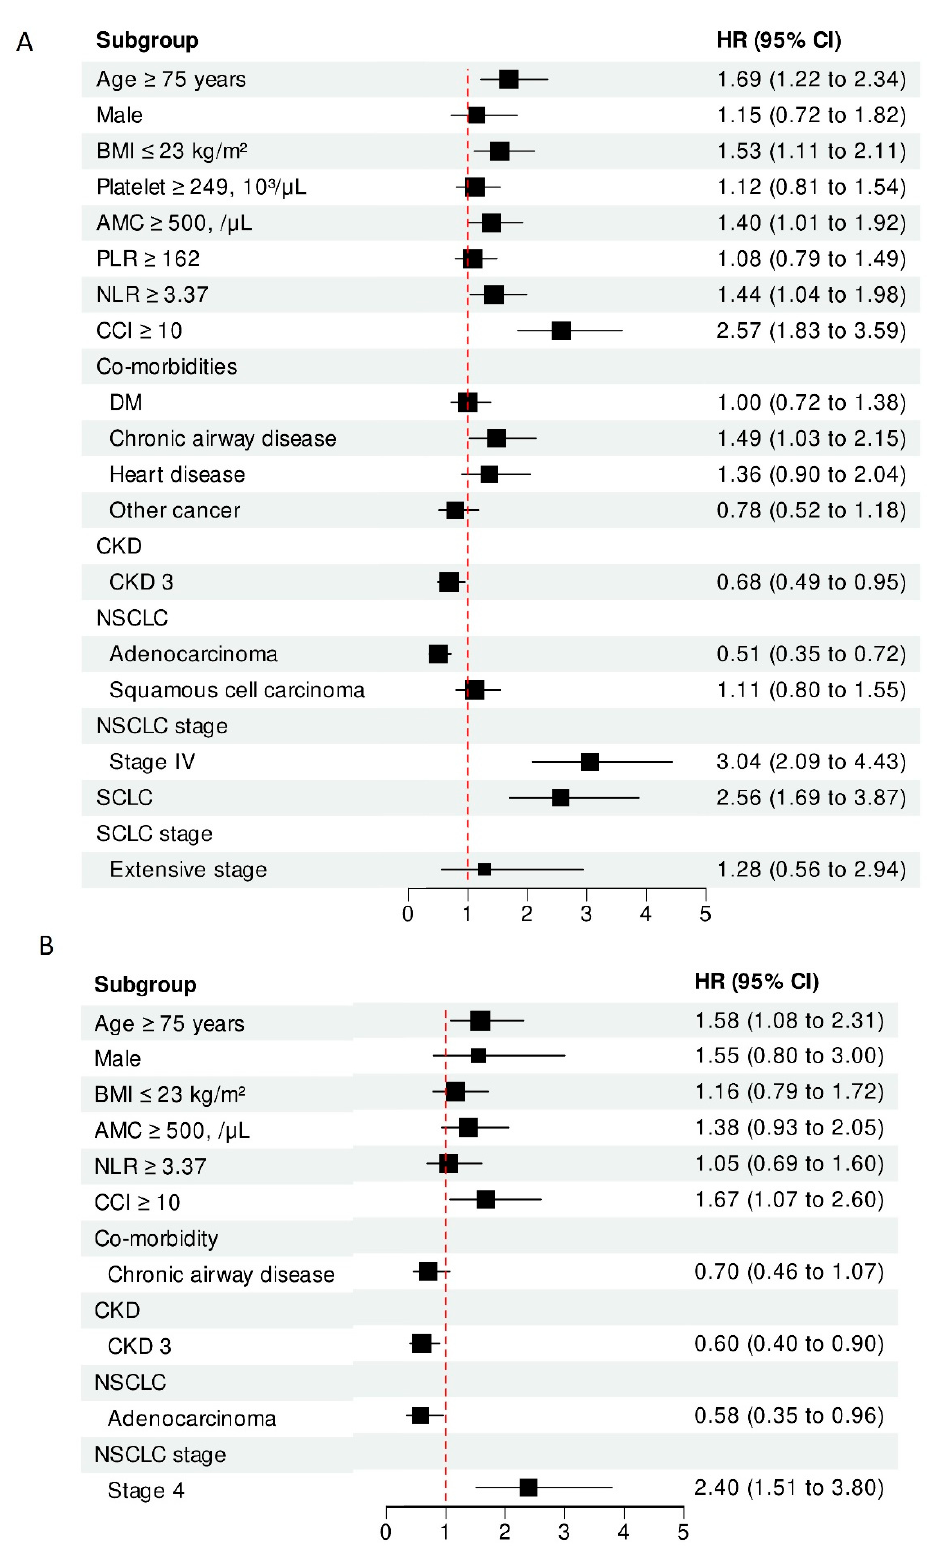
Figure 3. A forest plot of ( A ) univariate regression analysis and ( B ) multivariate regression analy- sis.